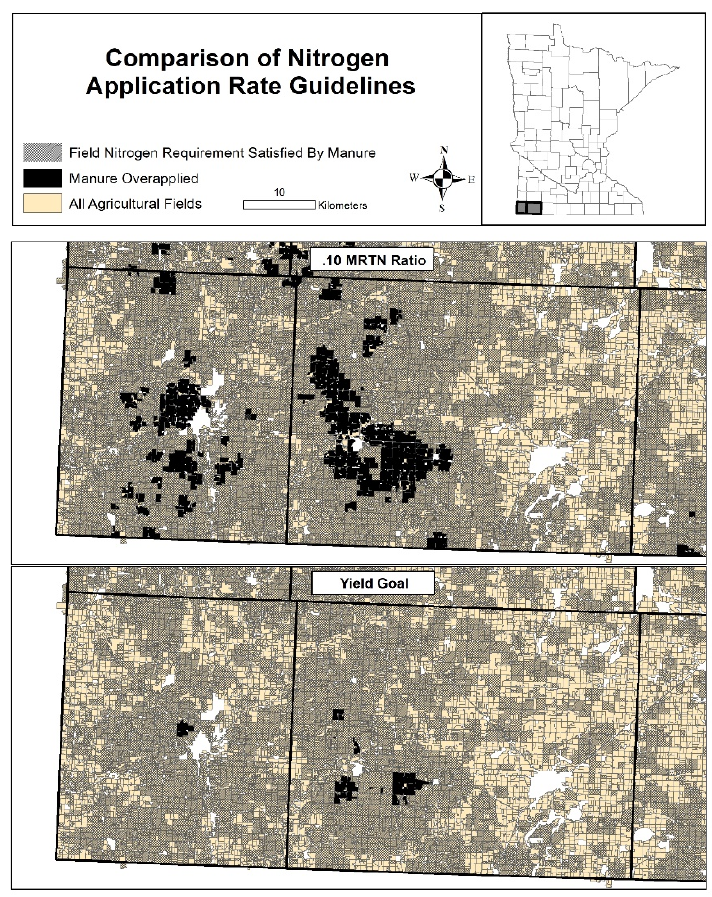
Figure 2. Change in Extent of Manure Application across N Rates (4.8 and 16 km haul distance).